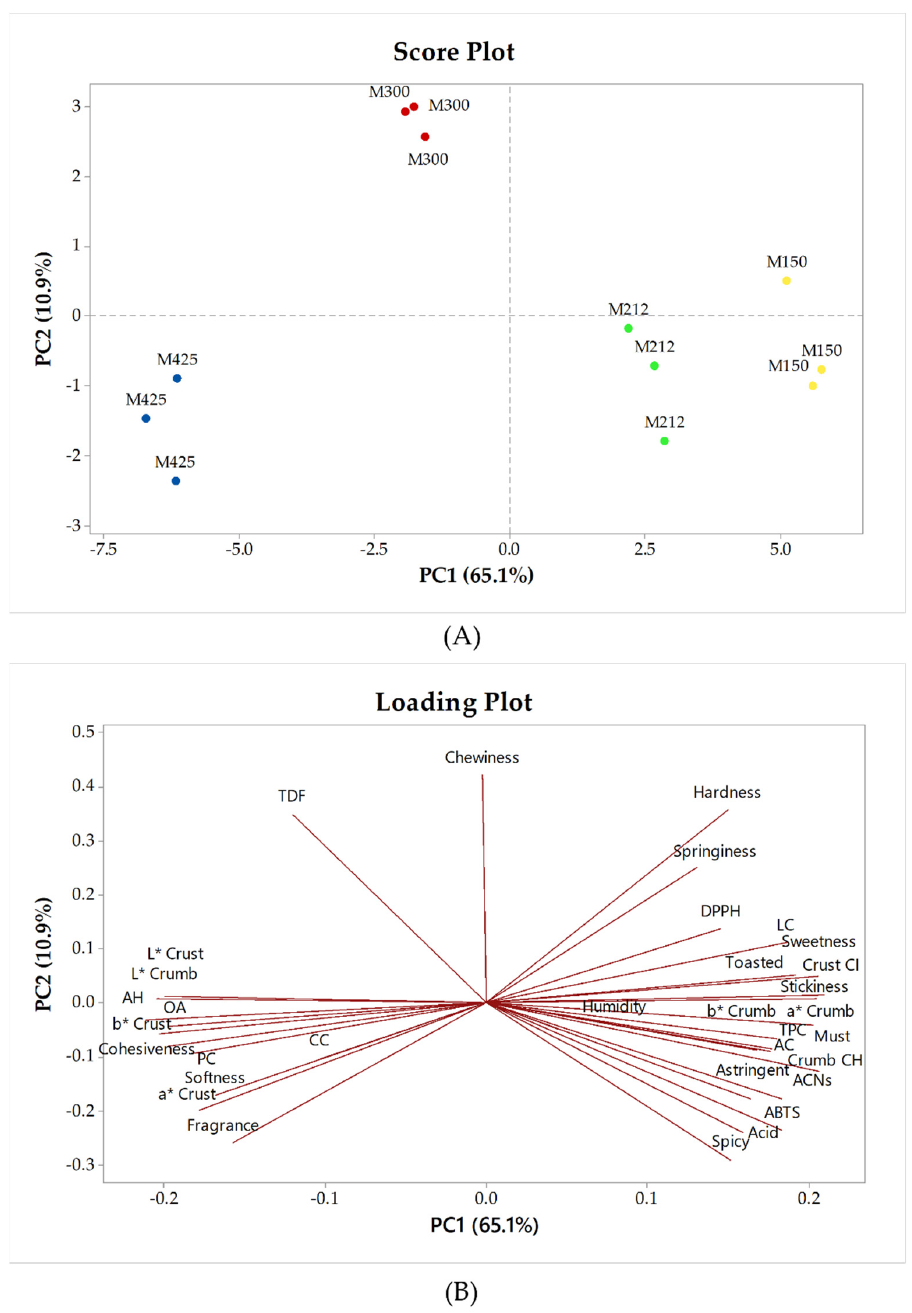
Figure 5. Score plot ( A ) and loading plot ( B ) of the principal component analysis (PCA) of experi ‐ mental muffins. M425, muffin with addition of grape pomace powder with a particle size of 425 μ m; M300, muffin with addition of grape pomace powder with a particle size of 300 μ m; M212, muffin with addition of grape pomace powder with a particle size of 212 μ m; M150, muffin with addition of grape pomace powder with a particle size of 150 μ m. TDF: total dietary fiber; AH: alveolus homogeneity; OA: overall acceptability; PC: protein content; CC: carbohydrate content; LC: lipid content; crust CI: crust color intensity; TPC: total phenol content; AC: ash content; crumb CH: crumb color homogeneity; ACNs: anthocyanins. 4. Conclusions This study explored the effect of the addition of grape pomace powder with different particle sizes on the chemical composition, textural and sensorial properties of enriched